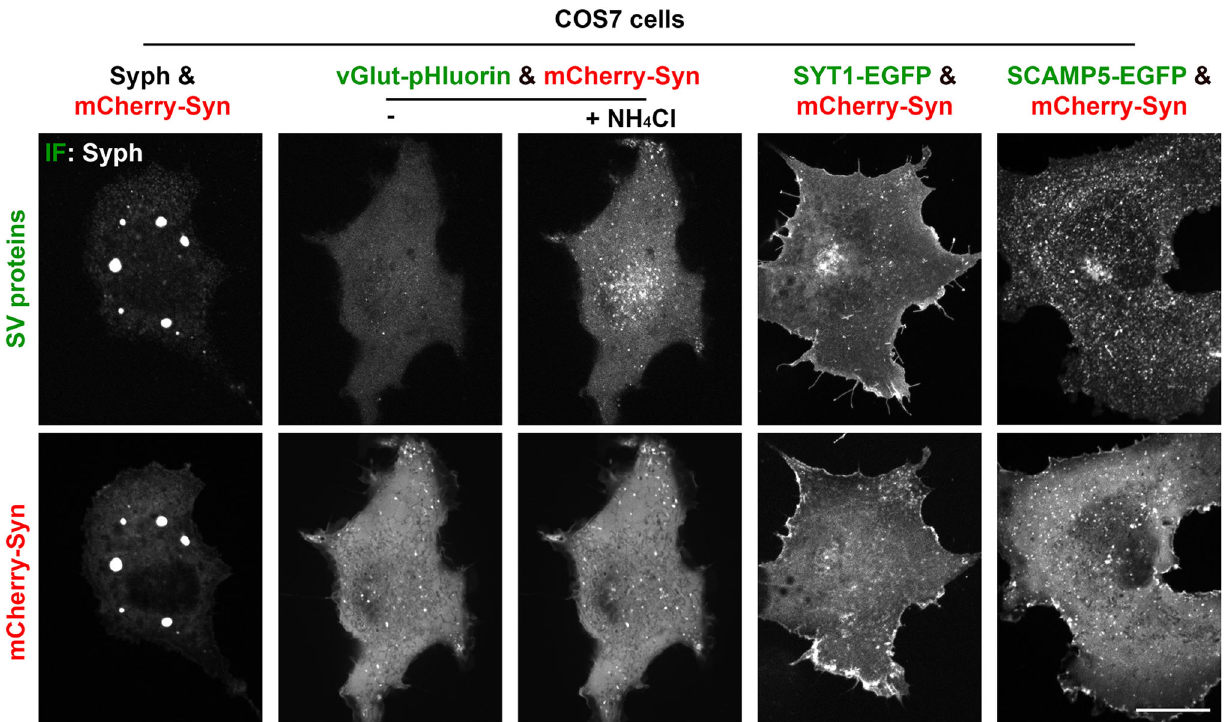
Fig. 5 Synapsin does not form droplets when it is expressed with other integral SV proteins in fi broblasts. COS7 cells were transfected with mCherry- synapsin and with synaptophysin, vesicular glutamate transporter (vGlut)-pHluorin, synaptotagmin I (SYTI)-EGFP or secretory carrier associated membrane protein 5 (SCAMP5)-EGFP. Synaptophysin was visualized by immuno fl uorescence and vGlut-pHluorin by alkalinization with NH 4 Cl to allow detection of the entire pool of this protein, including the pool localized on acidi fi ed vesicles. Note that only mCherry-synapsin and synaptophysin expressing cells (left) show droplets. Scale bar = 20 μ